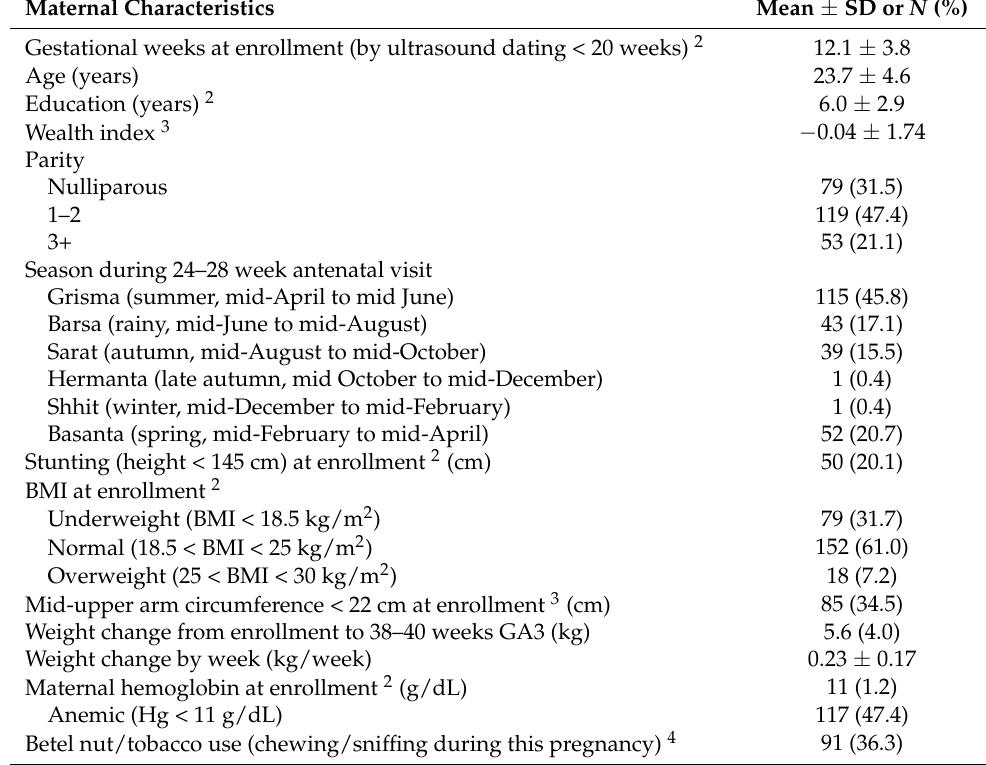
Table 1. Basic characteristics of Projahnmo study population ( N = 251) 1